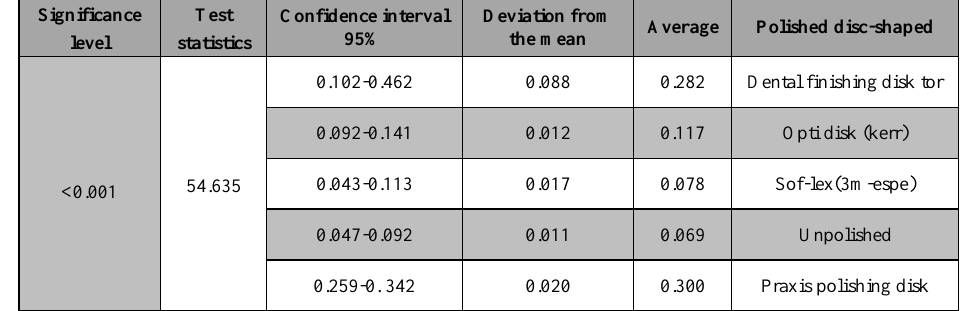
Polished disc-shaped Average